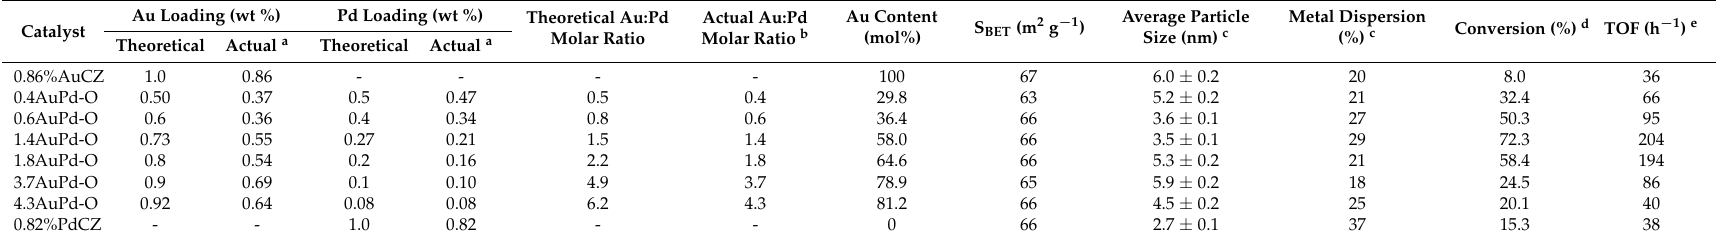
Table 1. Physicochemical properties of the monometallic and bimetallic